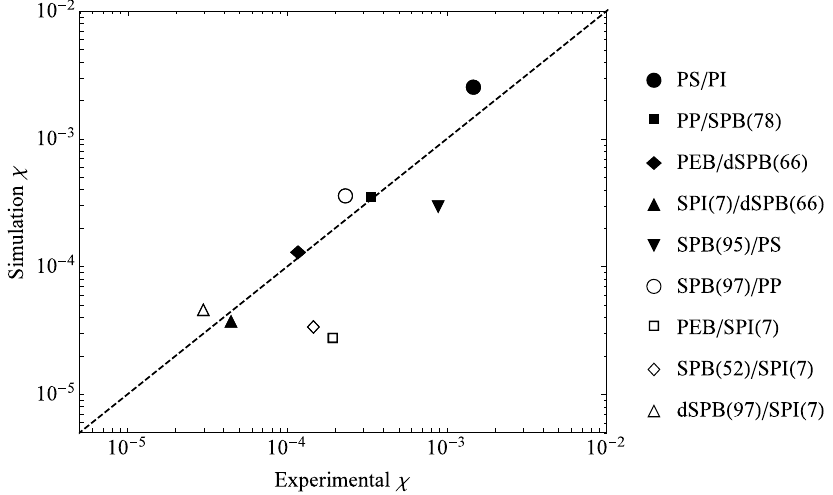
Figure 10. Scatter plot of χ per bead predicted by the simulation model vs. the entropic portion of experimental χ from the literature. Numbers in parentheses following the polymer labels indicate the degree of branching in mol %. A “d” preceding a polymer label indicates a deuterated polymer. Data can be found in Tables 2 and 3. Polymer abbreviations are defined in Table 4. Table 2. Data for real